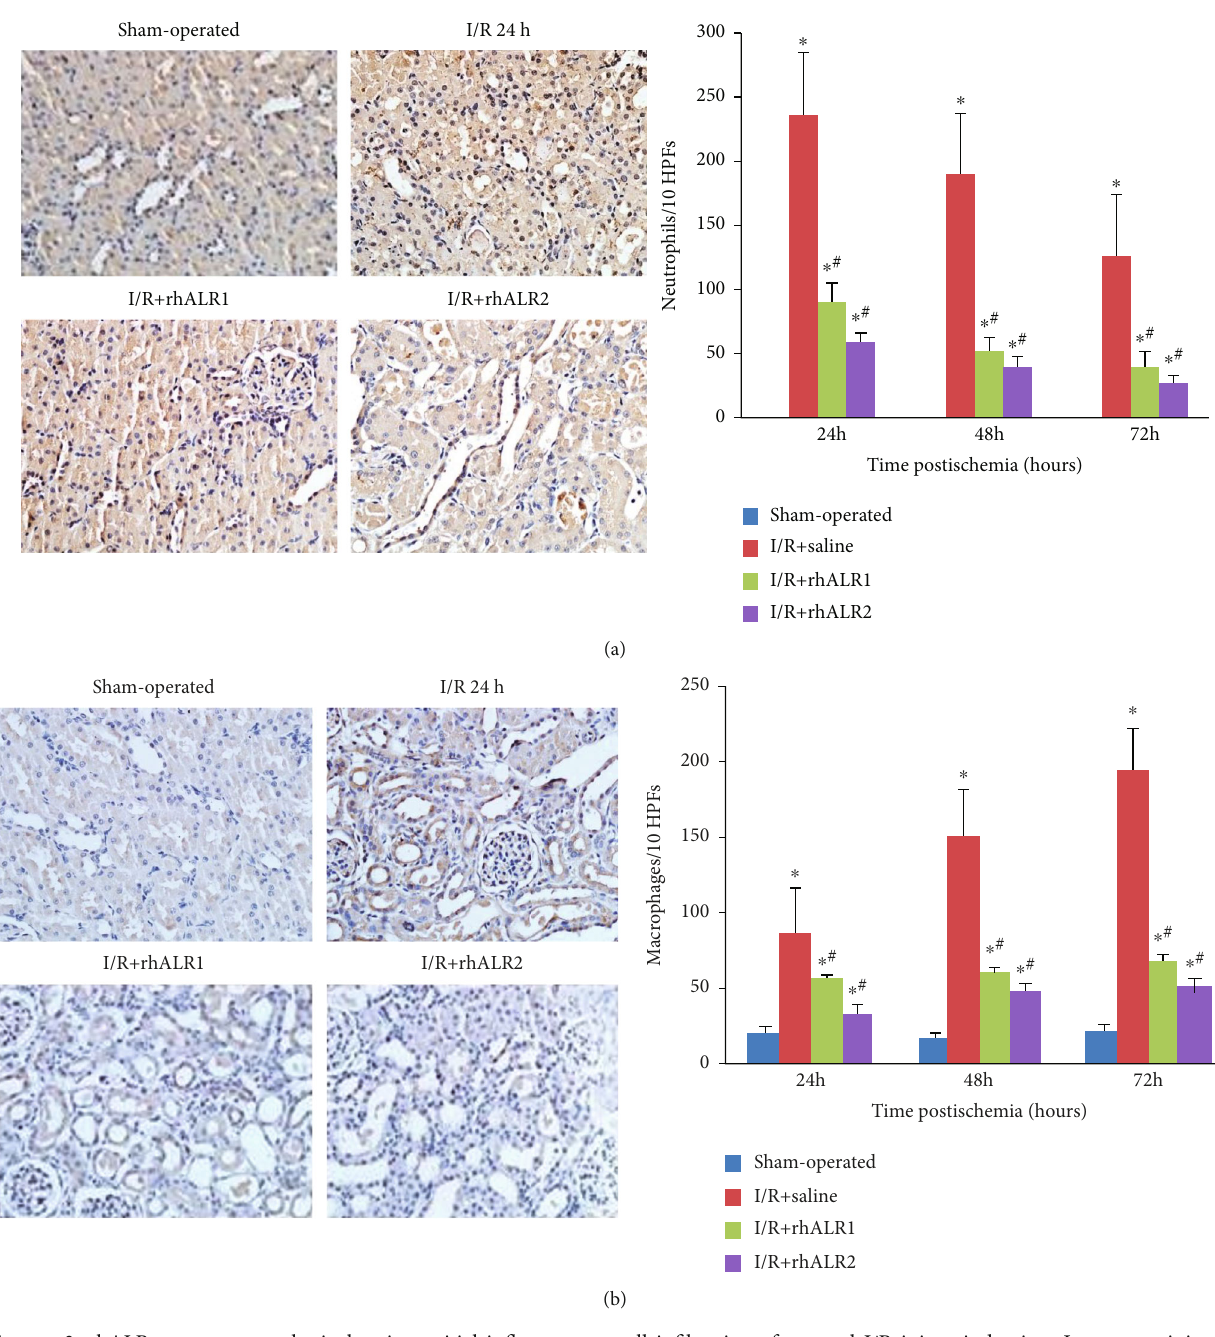
Figure 3: rhALR treatment results in less interstitial in fl ammatory cell in fi ltration after renal I/R injury induction. Immunostaining of CD11b (a) and CD68 (b) in the extrarenal medulla of rats was induced by sham operation or I/R injury 24-72 h after surgery. Sections at 72h are shown in (a, b) (magni fi cation: × 200). 10 HPF cells were counted in each section. After the induction of renal I/R injury, the number of neutrophils and macrophages increased rapidly and reached the peak at 24 and 72h, respectively. Exogenous rhALR reduced neutrophils and macrophage in fi ltration at both time points. All data were presented as the mean ± SD . ∗ P < 0 : 05 vs. sham, # P < 0 : 05 vs. I/R+saline